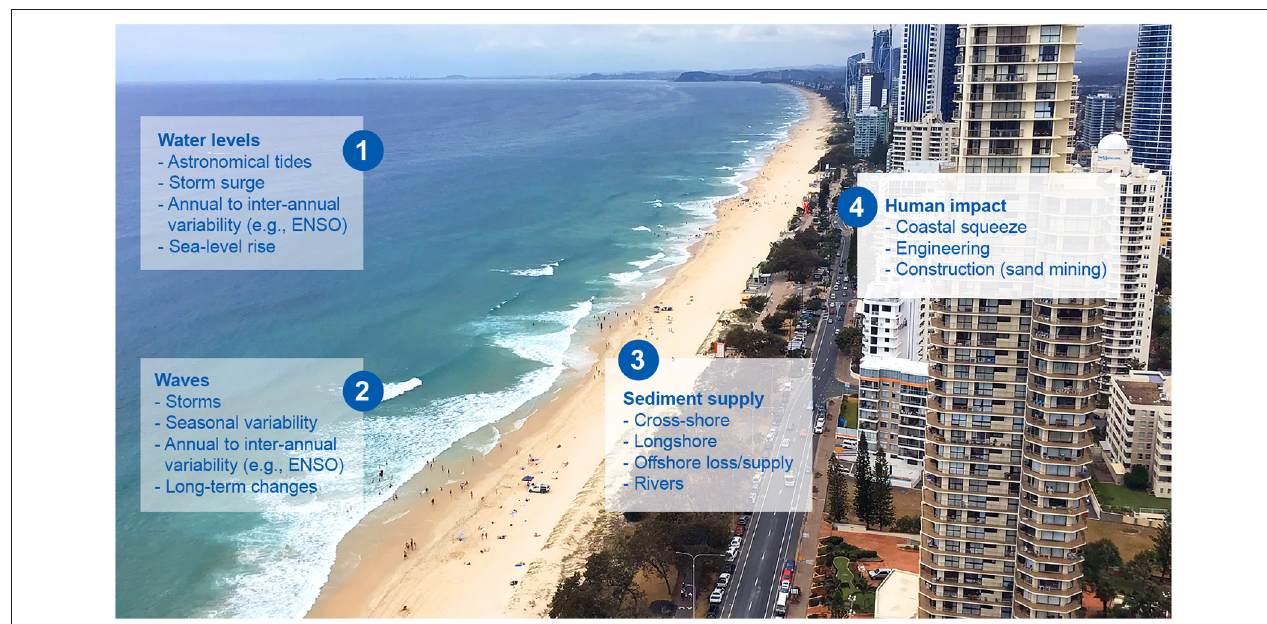
FIGURE 1 | Considerations relevant to shoreline modeling at a variety of timescales of interest. (1) Water levels; (2) Waves; (3) Sediment Supply; (4) Human Impact. These may be considered separately, in a combination, or all of them depending on the circumstances. Models can also consider these processes as deterministic or